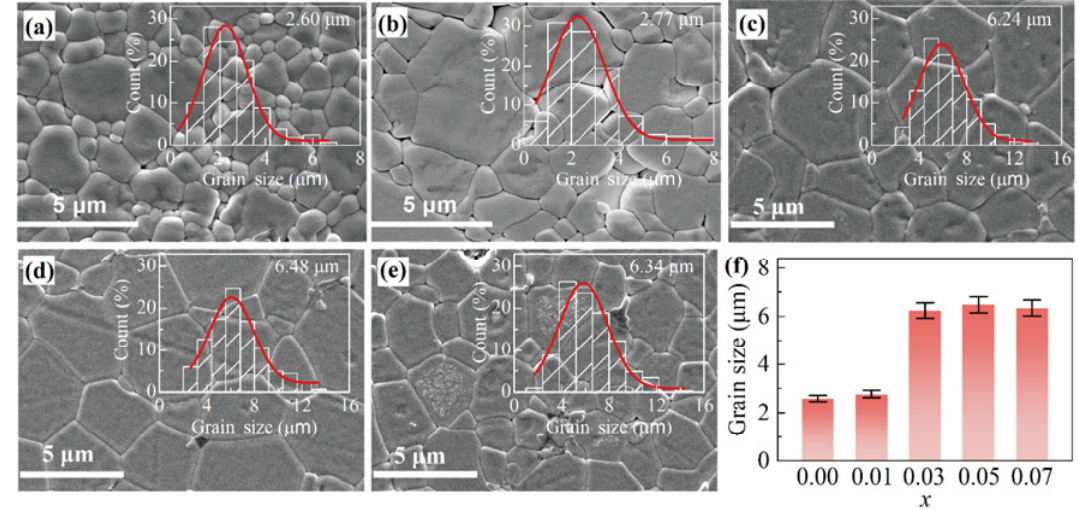
Fig. 2 SEM micrographs of PMN–PT– x BNZ ceramics; the insets show grain size distributions (calculated by Nano Measurer software) with Gaussian fitting: (a) x = 0.00, (b) x = 0.01, (c) x = 0.03, (d) x = 0.05, and (e) x = 0.07. (f) Grain size distributions of